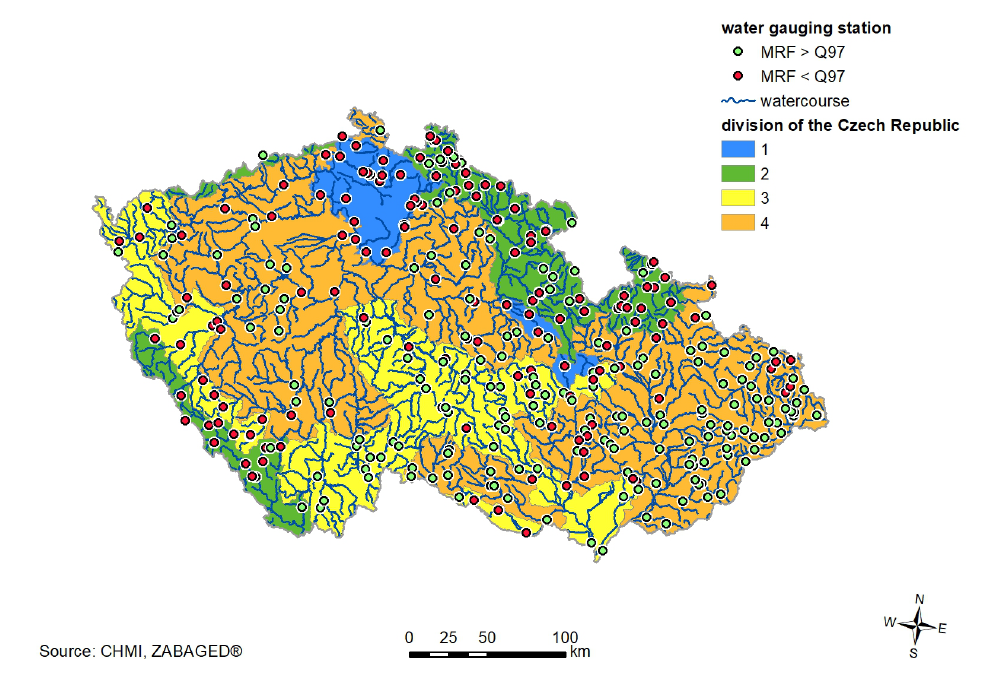
Figure 9. The impact of compensation coefficient (0.9) reduction on MRF values in relation to Q 97